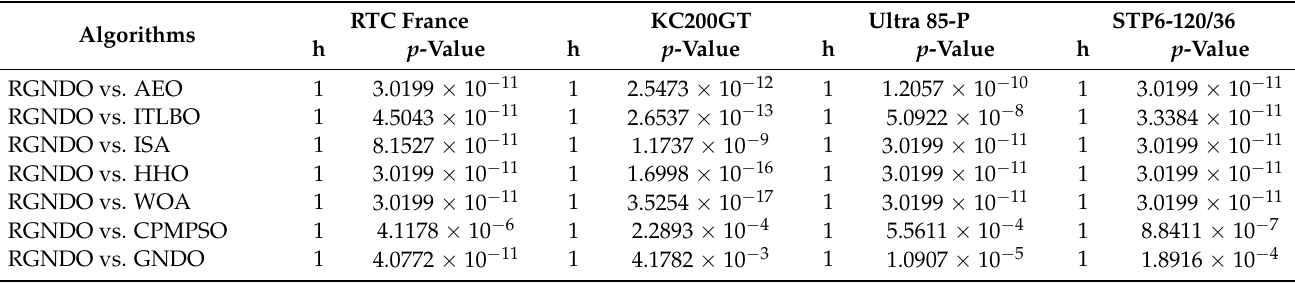
Table 13. Comparison between the proposed with the others under the Mann–Whitney U Test.